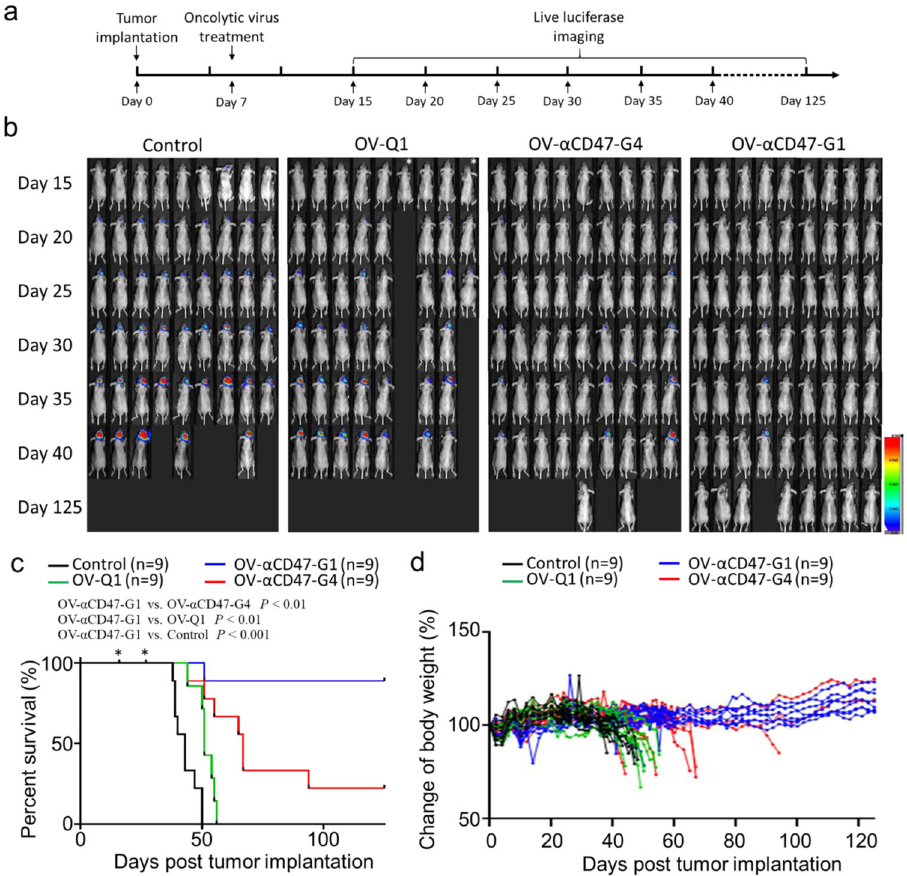
Fig. 5 Comparison of the effectiveness of OV- α CD47-G1 versus OV- α CD47-G4 to improve in vivo oncolytic virotherapy of GBM in an orthotopic model of human GBM. a Experimental timeline for in vivo studies. An orthotopic model of human GBM was established by i.c. injection of 1 × 10 5 GBM43- FFL human GBM cells into athymic nude mice. Seven days later, mice were intratumorally injected with vehicle control or 2 × 10 5 PFU of OV-Q1, OV- α CD47-G1, or OV- α CD47-G4. b Time-lapse luciferase imaging of GBM43-FFL growth in mice with indicated treatments. c Survival of GBM43-FFL tumor- bearing mice treated as described in ( a ). Survival was estimated by the Kaplan – Meier method and compared by two-side log-rank test ( n = 9 animals). *Two mice in the OV-Q1 control group died accidentally after i.p. injection of luciferin on days 16 and 27 without obvious GBM symptoms. d Individual body weights of the experimental mice were recorded once every other